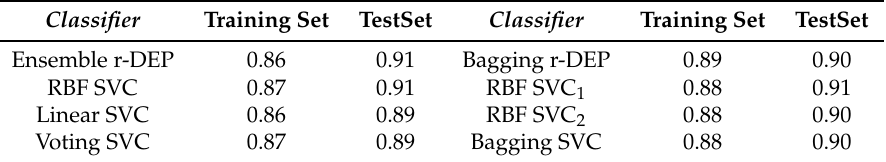
Table 1. Accuracy score of the classifiers considered in Example 6 on Ripley’s dataset.